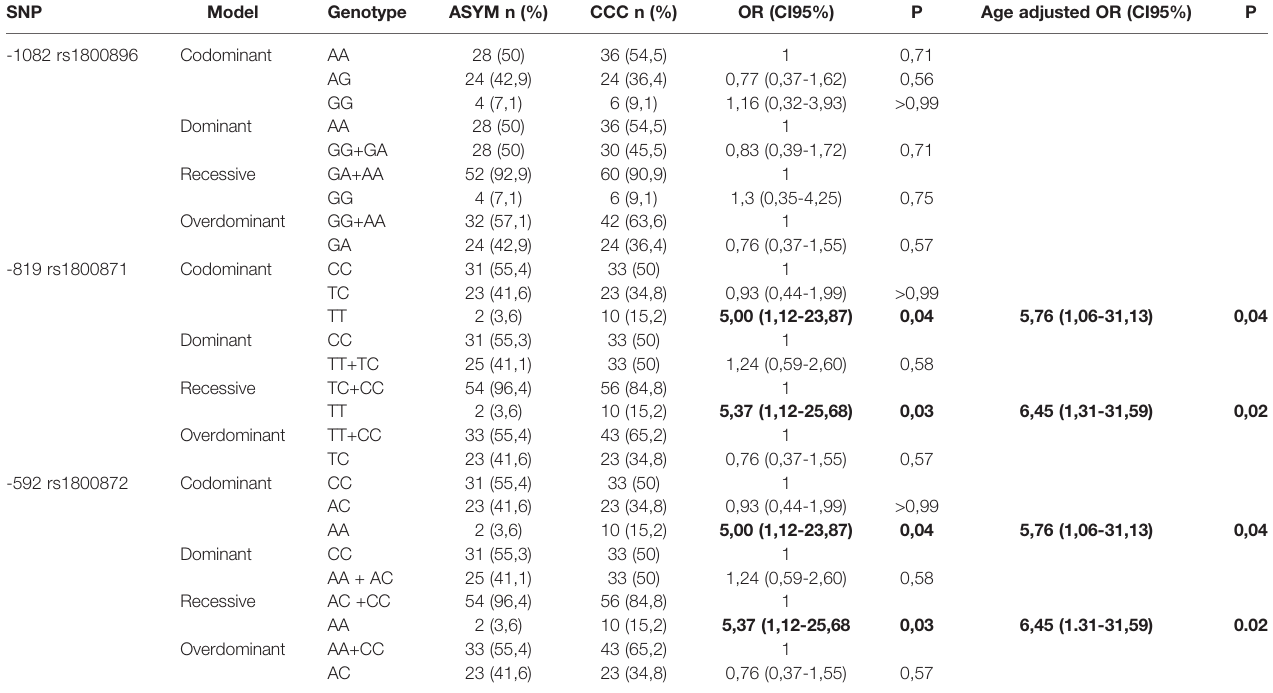
The bold text represents the statistically signi fi cant results